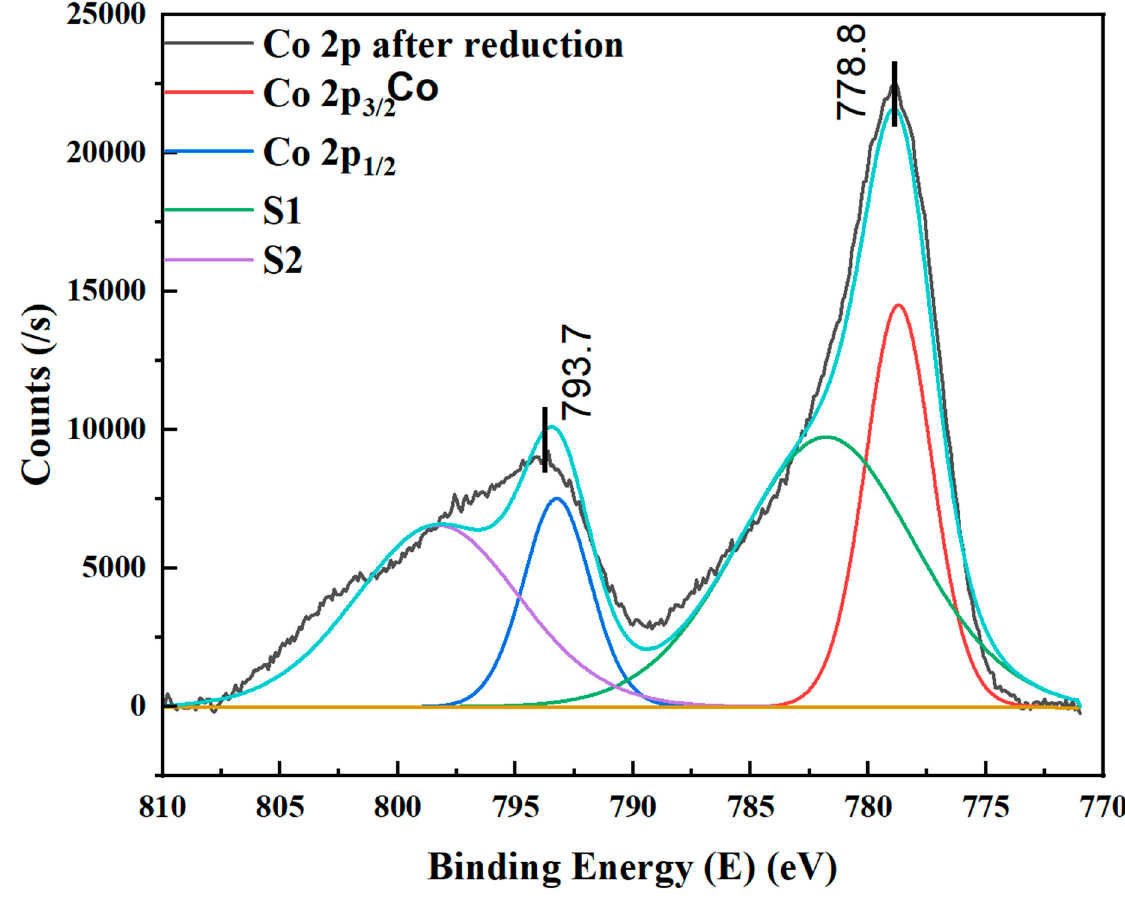
Figure 7. XPS spectra of reduced cobalt film in the microchannels of silicon microreactor .